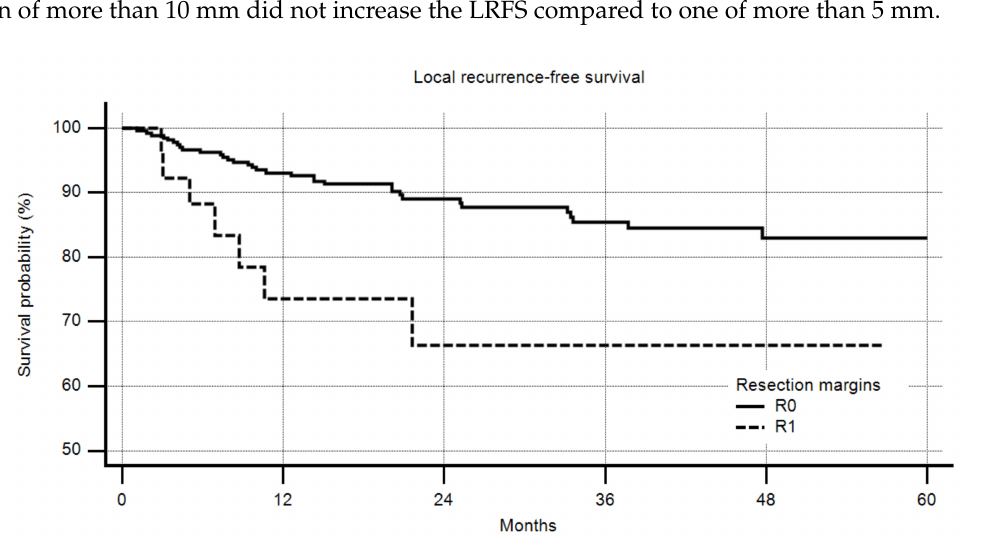
Figure 1. Local recurrence-free survival by margin (R0 vs. R1), R2 excluded, n = 301, 5-year R0 83%, 5-year R1 66%, p = 0.0194.